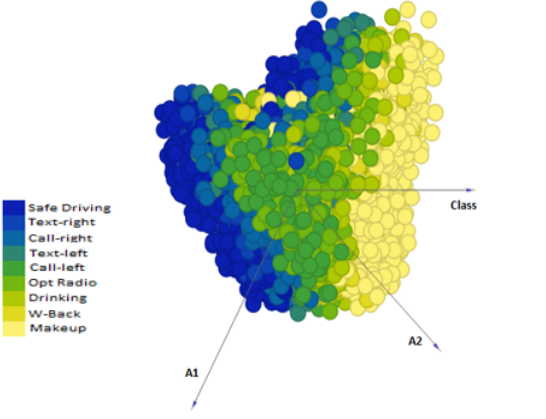
Figure 13. Linear projection showing the features (first two principal components) of pooling layer of proposed approach of SFDDD dataset for driver distraction detection including safe driving, texting—right, talking on the phone—right, texting—left, talking on the phone—left, operating the radio, drinking, reaching behind, hair and makeup, and talking to a